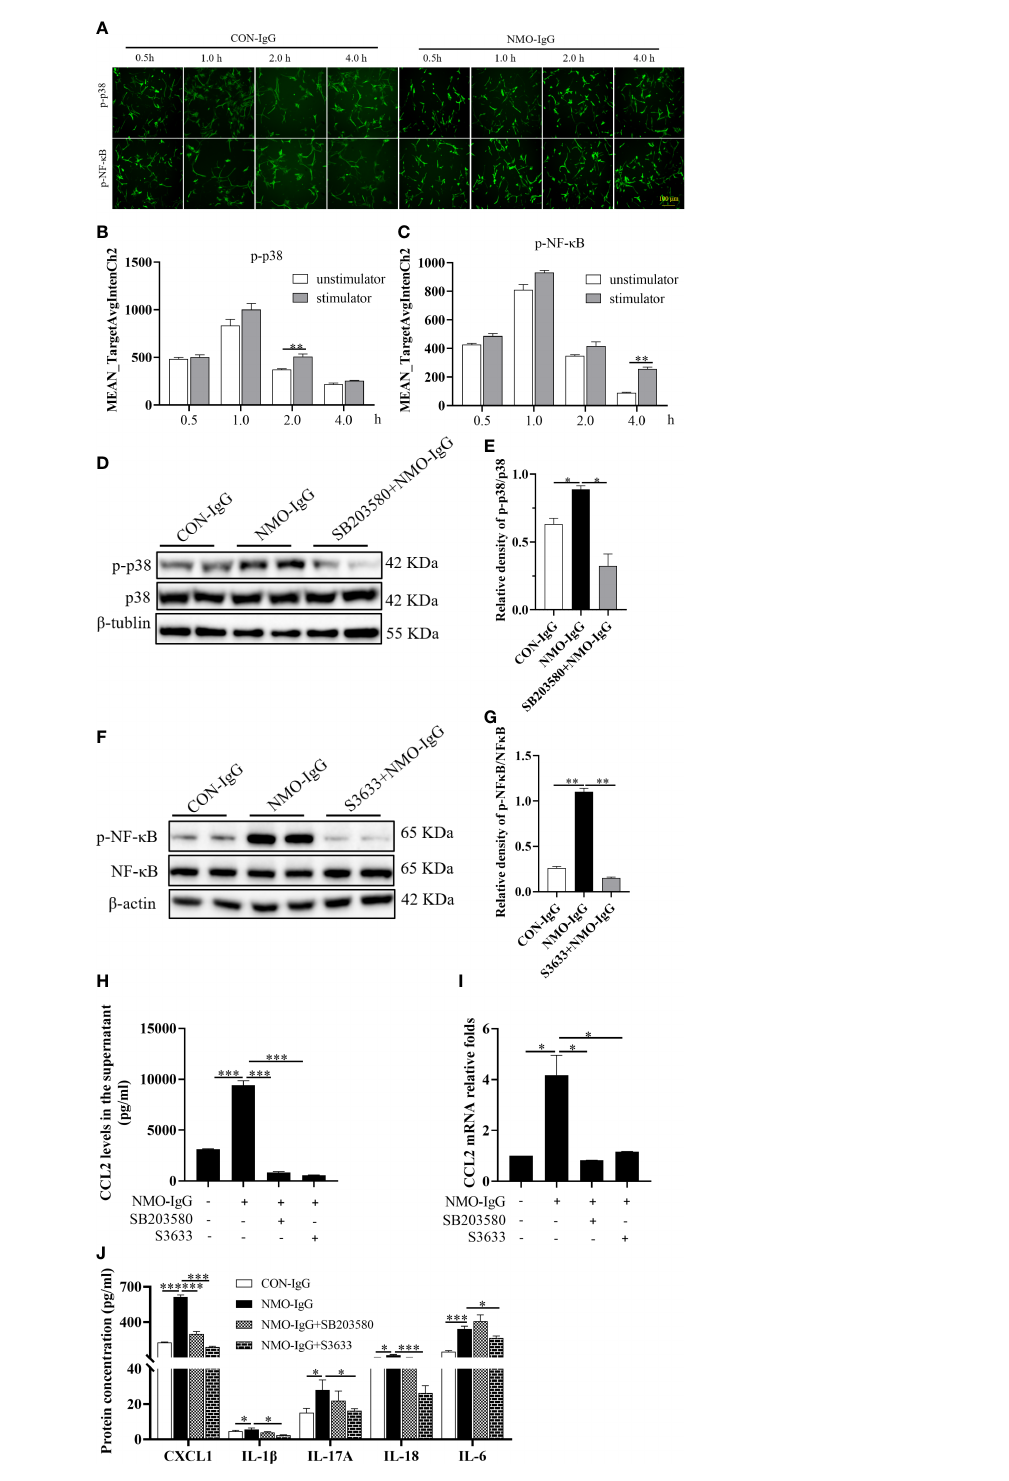
FIGURE 6 MAPK p38 and NF- k B signaling activation is involved in the CCL2 increase induced by NMO-IgG. (A) After cell incubation with NMO-IgG for 0.5, 1.0, 2.0, or 4.0 hours, the intracellular immunocytochemical fl uorescence staining of p-p38 and p-NF- k B was analyzed using the high-content screening analyzer. Scale bar = 100 m m. (B, C) The fl uorescence intensity of phosphorylated p38 and NF- k B was signi fi cantly increased at 2 or 4 hours after NMO-IgG stimulation ( n =4), respectively. (D, E) After preincubation for 0.5 hours with the p38-selective inhibitor SB203580 (100 m M), astrocytes were stimulated with NMO-IgG, and the obvious activation of p38 signaling pathways was almost prevented by SB203580 ( n =2). Data are presented as the mean ± SE. * p < 0.05. (F, G) Meanwhile, when astrocytes were pretreated for 0.5 hours with the NF-kB signaling pathway-speci fi c inhibitor S3633 (100 mM) ahead of NMO-IgG stimulation, NF- k B phosphorylation was reversed. In addition, the release of CCL2 proteins into the supernatant (H) and CCL2 mRNA expression (I) were markedly prevented by either SB203580 or S3633. (J) S3633 signi fi cantly inhibited the production of CXCL1, IL-1 b , IL-17A, IL-18, and IL-6, whereas SB203580 inhibited only the production of CXCL1. Data are presented as the mean ± SE of three independent experiments. * p < 0.05, ** p < 0.01, and *** p <